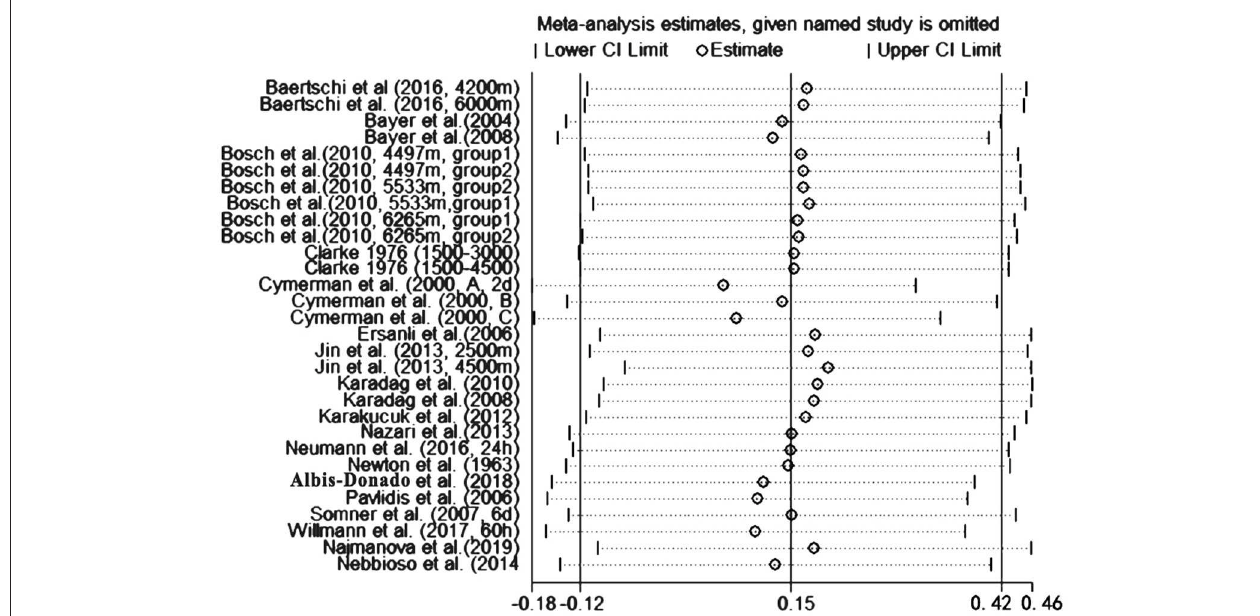
FIGURE 7 | Sensitivity analysis changes in IOP during high altitude exposure.